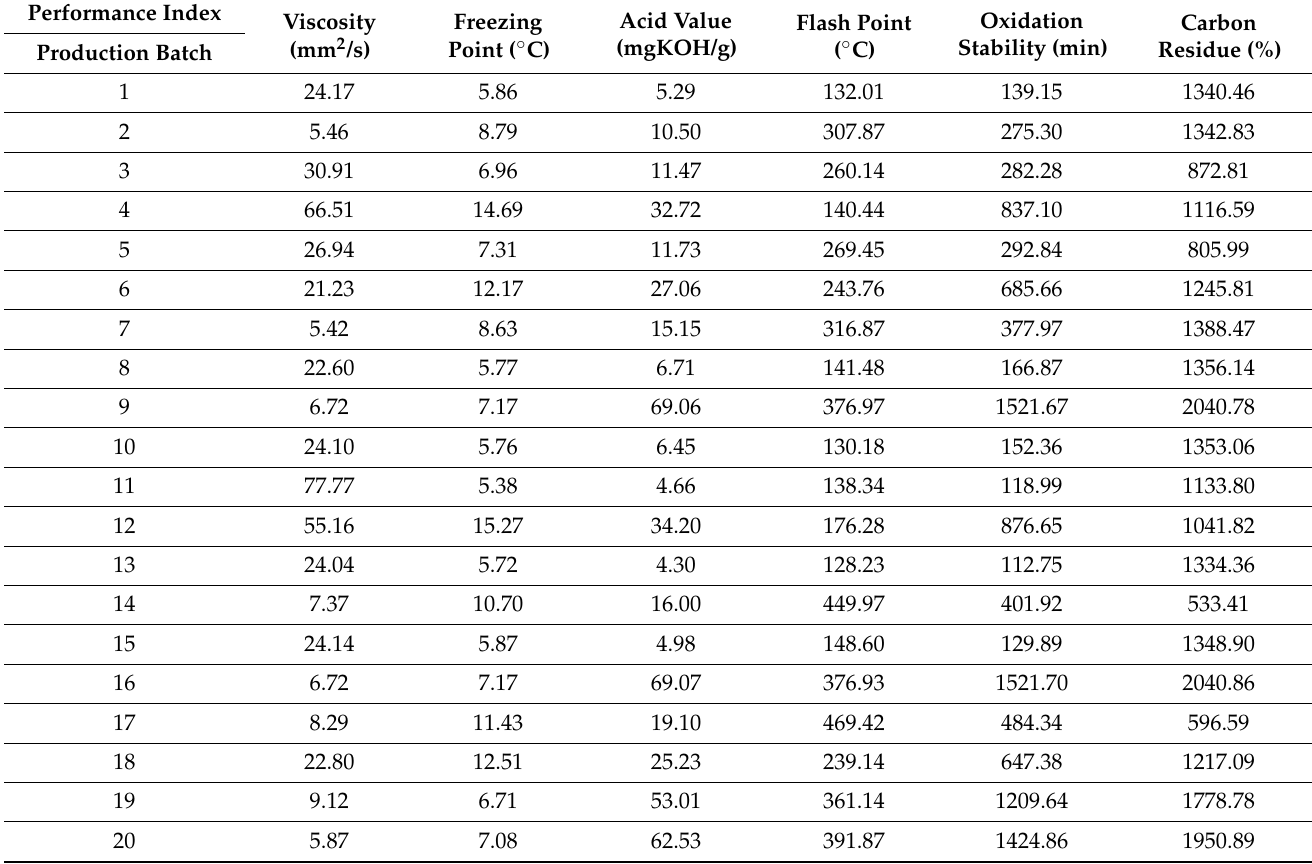
Table 3. Performance indexes of each batch of blended